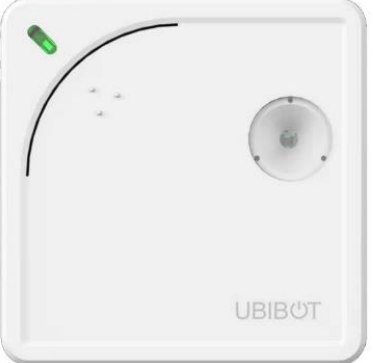
Figure 8. Style of sensor.